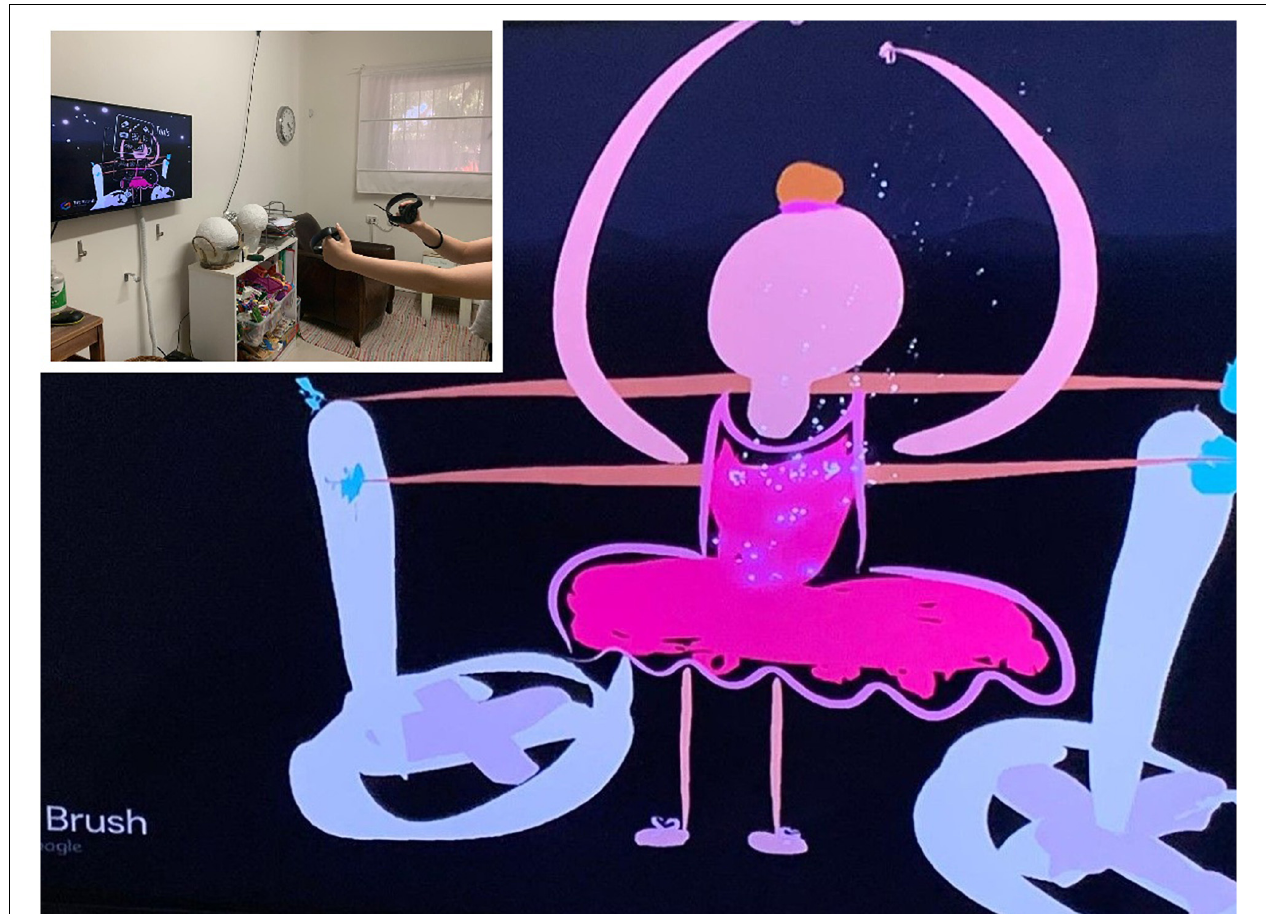
FIGURE 5 | Alma’s